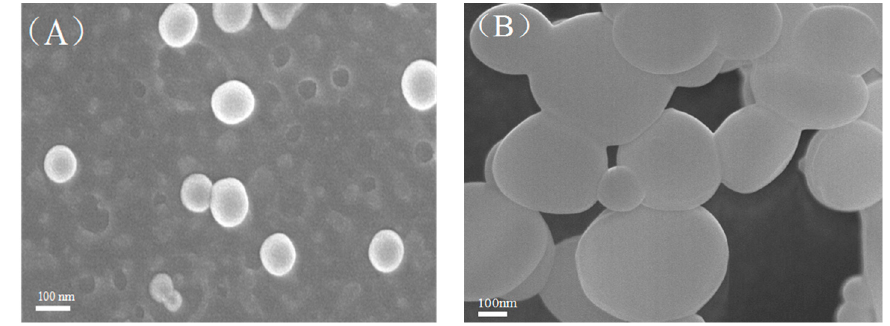
Figure 11. The SEM of polymer solutions with different temperatures (( A) < LCST, ( B) > LCST). Therefore, for a sample with M w (1.04 × 10 5 ), a reasonable explanation is HPNPAM molecules form uniform nanomicelles due to the amphiphilic macromolecules backbone. When the temperature was higher than the LCST, hydrogen bonds between HPNPAM and the solvent were broken.